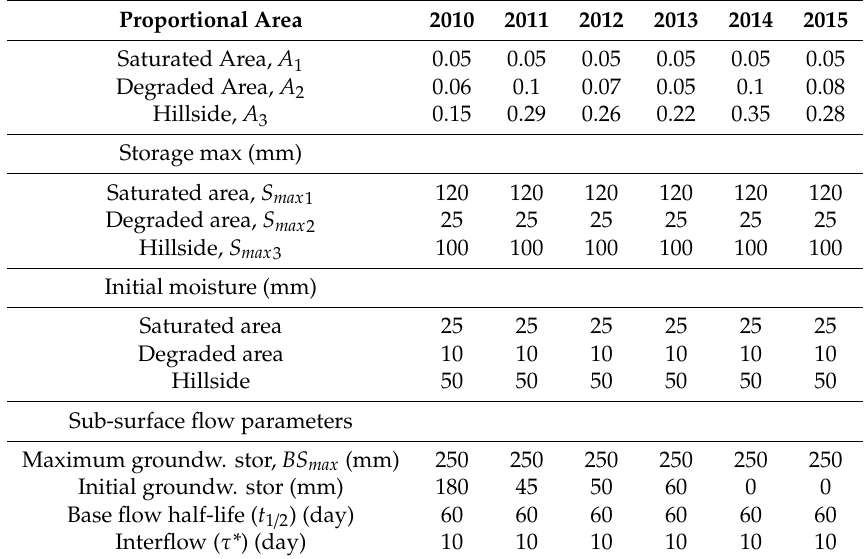
Table 3. Parameter E ffi cient Distributed (PED) model parameters of the Tikur-Wuha watershed from 2010 to